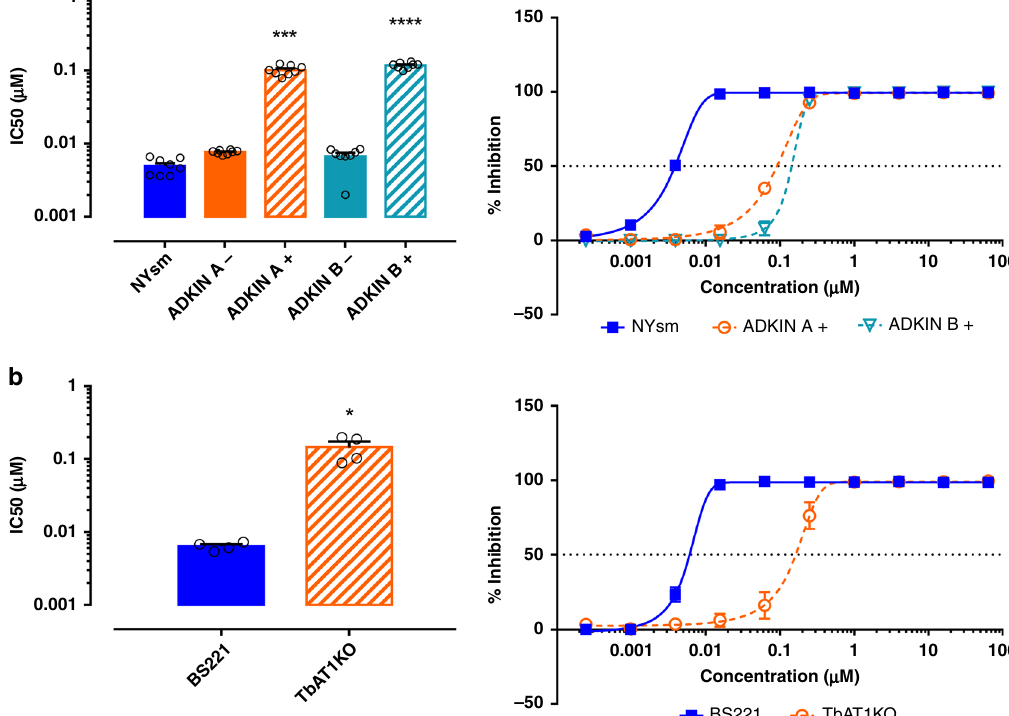
Fig. 4 Susceptibility of ADKIN RNAi-mediated knockdown and TbAT1-KO cell lines to 9 . a Sensitivity of the RNAi clones targeting adenosine kinase (ADKIN). b Sensitivity of AT1-KO T. b. brucei strain, compared to the BS221 cell line from which it was derived. Results are expressed as the mean IC 50 ( µ M), and error bars represent SEM and are based on two independent experiments ( n = 2), each with two biological replicates. + = tetracycline-induced clones; − = non-induced clones. All experiments were performed with two independently generated RNAi clones ( a , b ). * P < 0.05, *** p < 0.001, **** p < 0.0001, Kruskal – Wallis test with Dunn ’ s multiple comparison test. Source data are provided as a Source Data fi (Fig. 3c). Dose titration at 25, 12.5 and 6.25 mg kg − 1 s.i.d. for